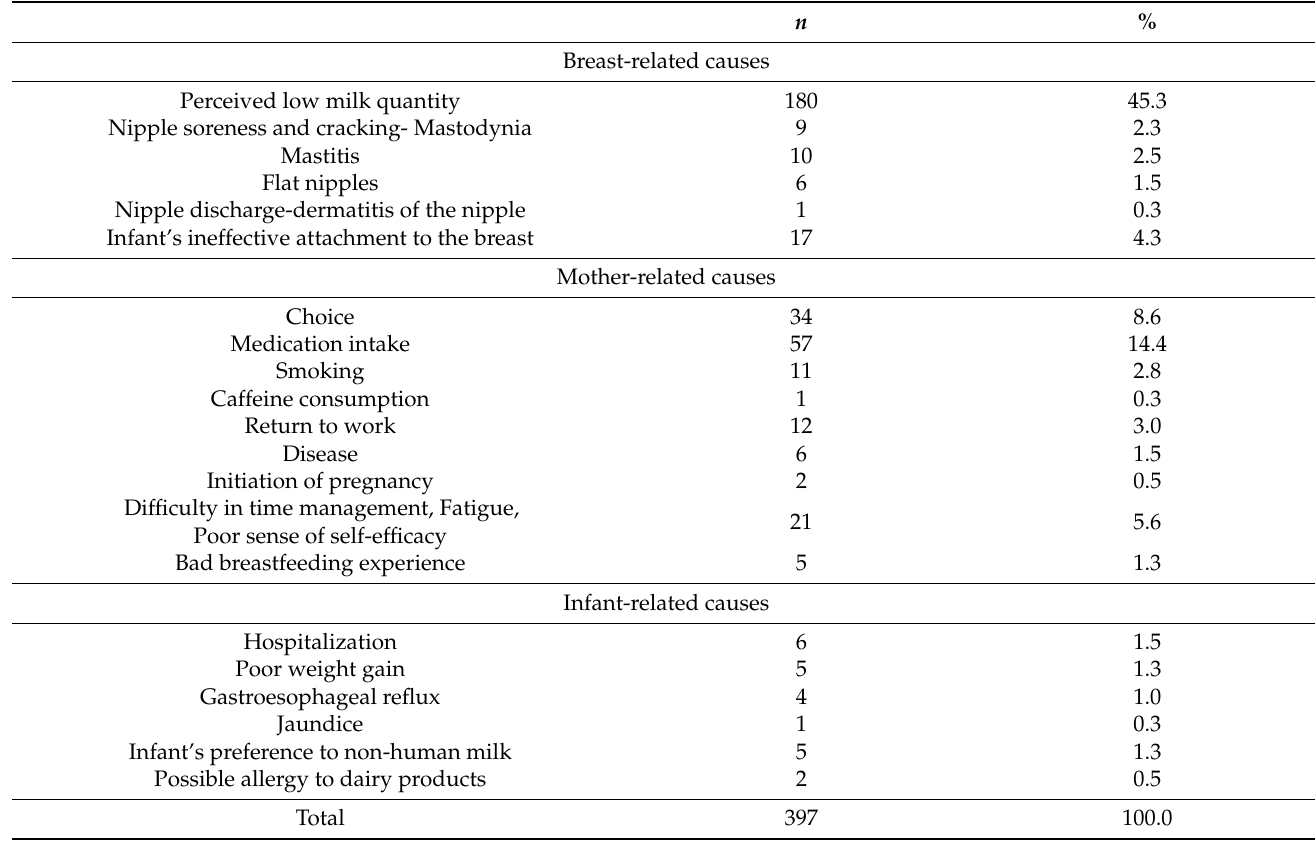
Table 3. Causes of breastfeeding